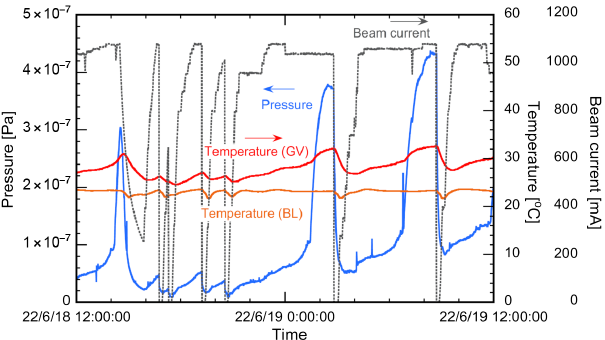
FIG. 34. Behaviors of the beam current, pressure, and temper- atures of a gate valve (GV) and a bellows chamber (BL) on the 18th and 19th of June,